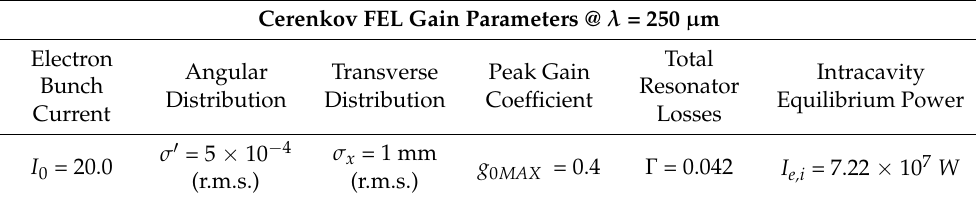
Table 2. Cerenkov FEL Gain Parameters @ λ = 250 µ m.